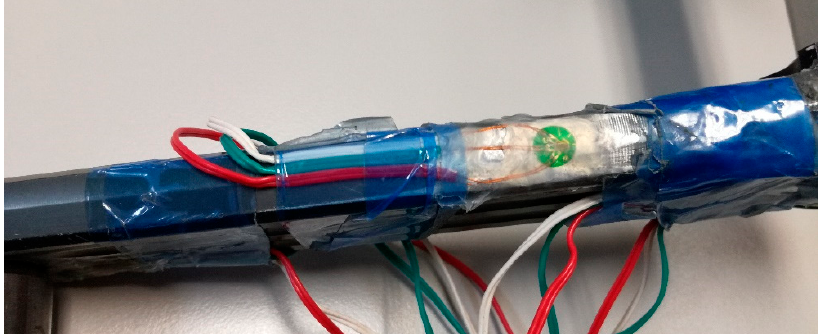
Figure 2. Position of the strain gauge rosette #2.